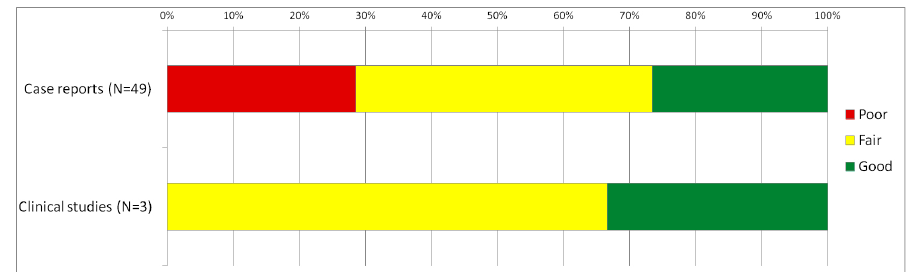
Figure 3. Assessed quality for the identified available sources.